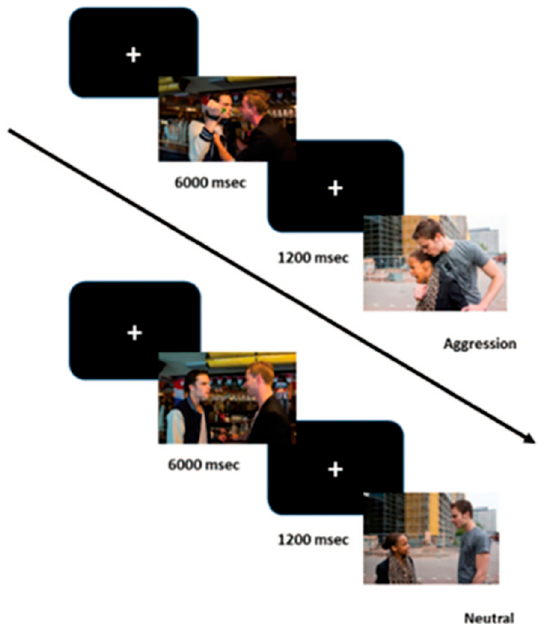
Figure 1. Passive viewing task with pictures of aggressive interactions and neutral interactions serving as control pictures.